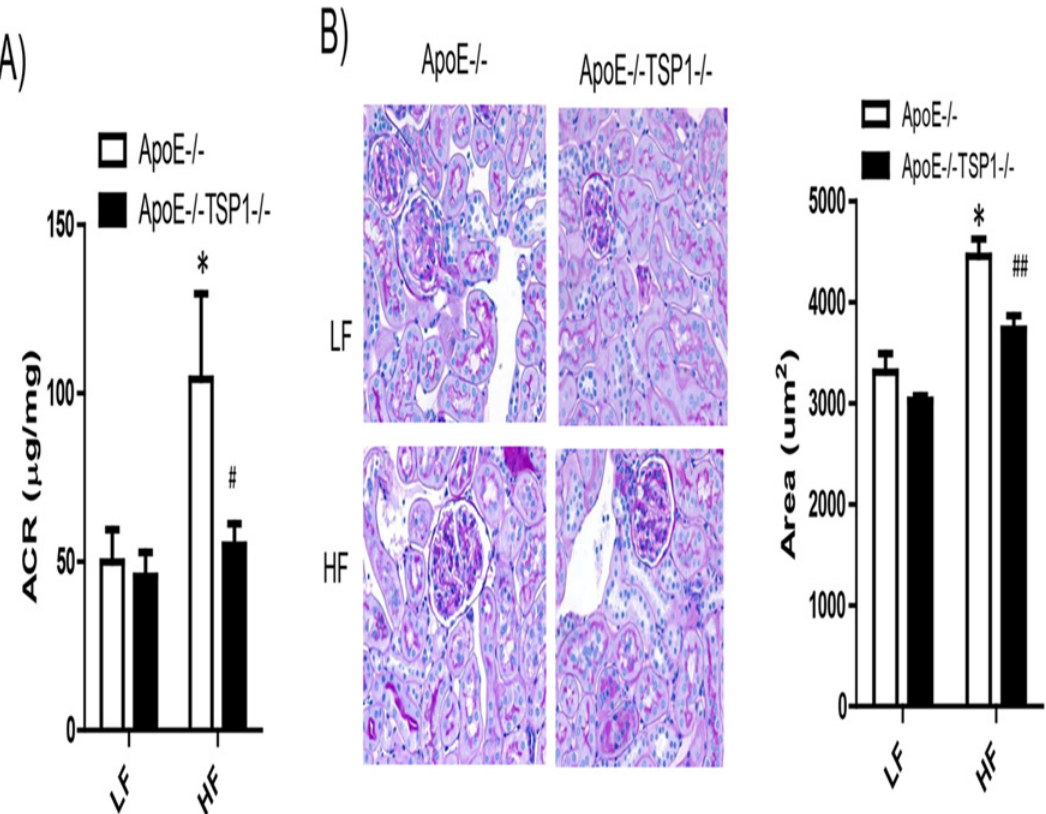
Fig 7. TSP1 deficiency attenuated obesity associated kidney dysfunction in ApoE-/- mice. A). Urinary albumin-to-creatinine ratio (ACR) was examined. B). Representative light micrographs of periodic acid-Schiff (PAS) stained kidney sections from 4 groups of mice. C) Glomerular area was analyzed by computer image analysis software. * P < 0.05 vs. LF ApoE-/-. # P < 0.05, ## P < 0.01vs. HF